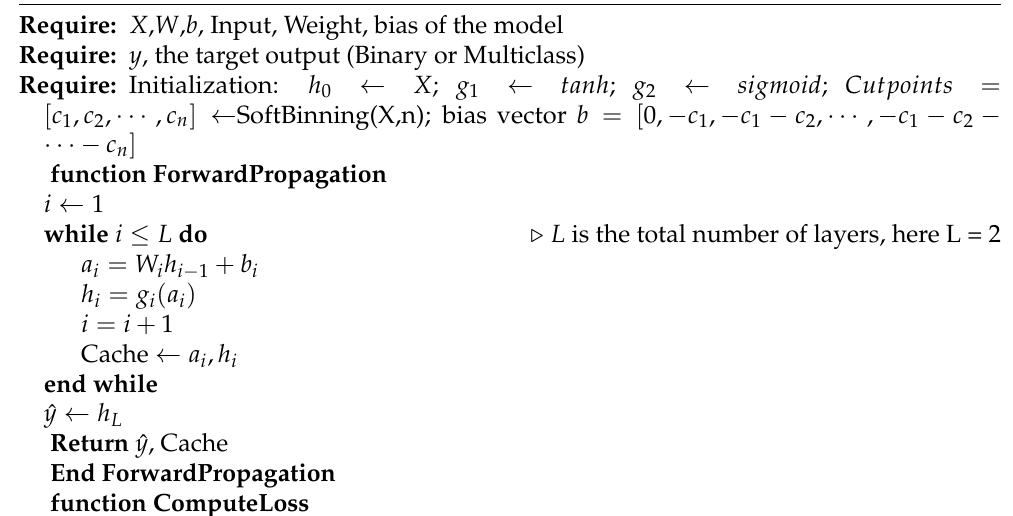
Algorithm 2 Decision Tree-Based Deep Neural Network (DTBDNN)